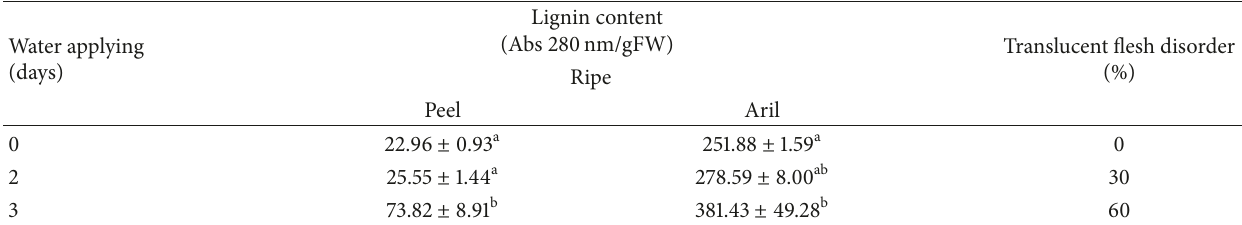
Table2:Theinfluenceofappliedwateratfruitsurfaceofon-treematuregreenmangosteenfruitonlignininductionandtriggeringtranslucent flesh disorder. The values were mean ± SE ( 𝑛 = 4 ). Different letters in each column showed dissimilarity from Tukey’s (HSD) test ( 𝑃 < 0.05